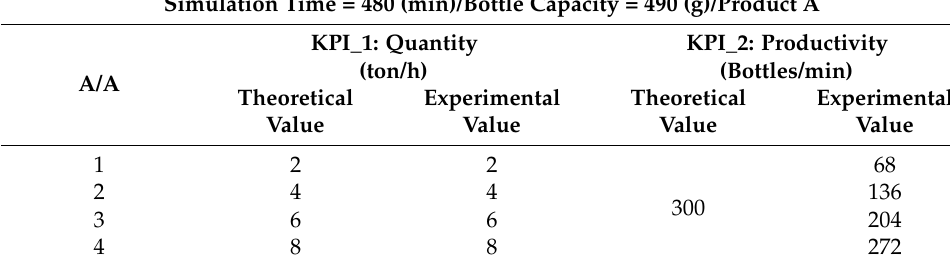
Table 15. Results of Digital Model—After the Implementation of Proposed